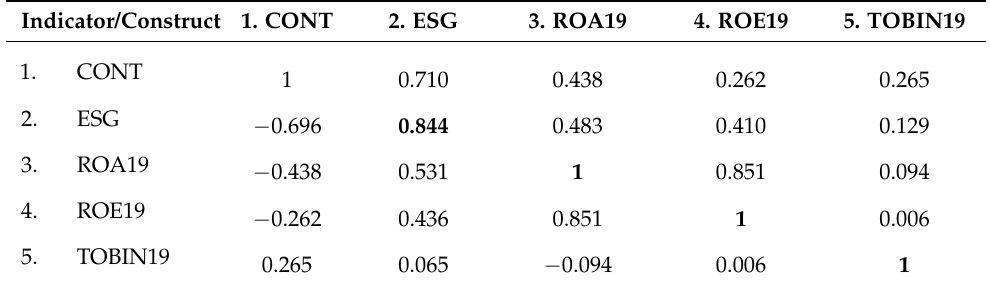
Table 3. Fornell and Larcker, and Heterotrait–Monotrait criteria to assess discriminant